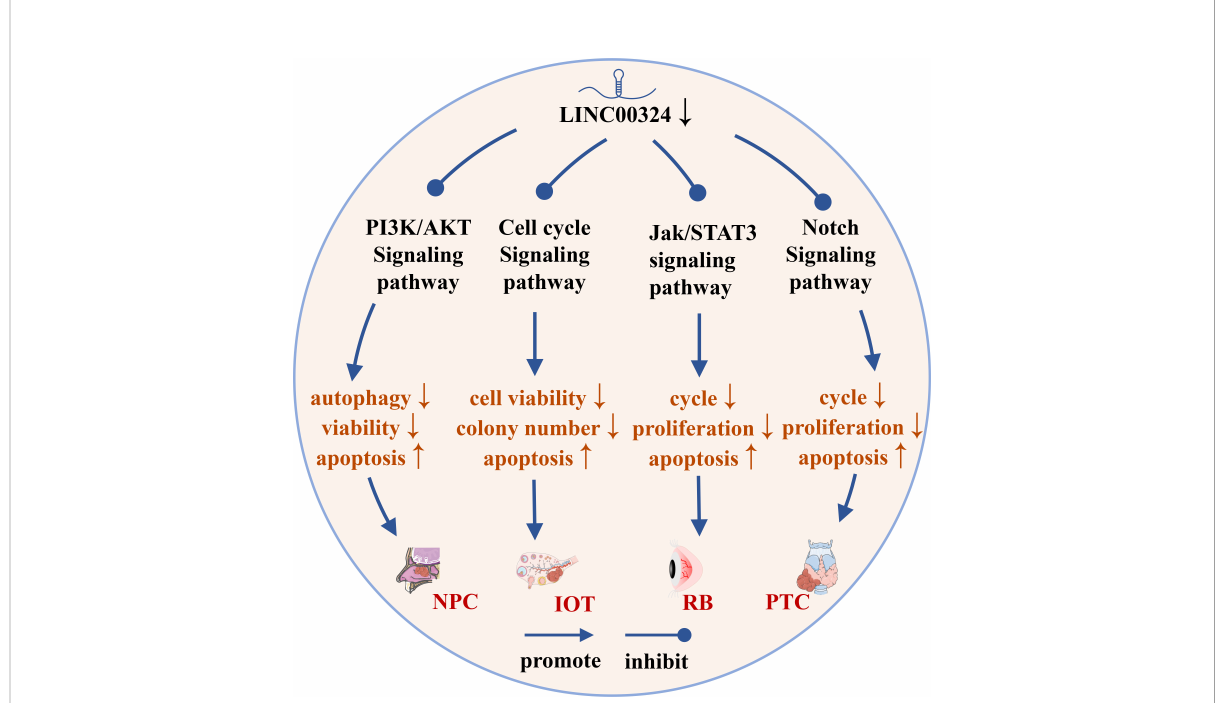
FIGURE 4 The role of LINC00324 in signaling pathways. IOT, Immature ovarian teratocarcinoma; NPC, Nasopharyngeal carcinoma; PTC, Papillary thyroid cancer; RB,